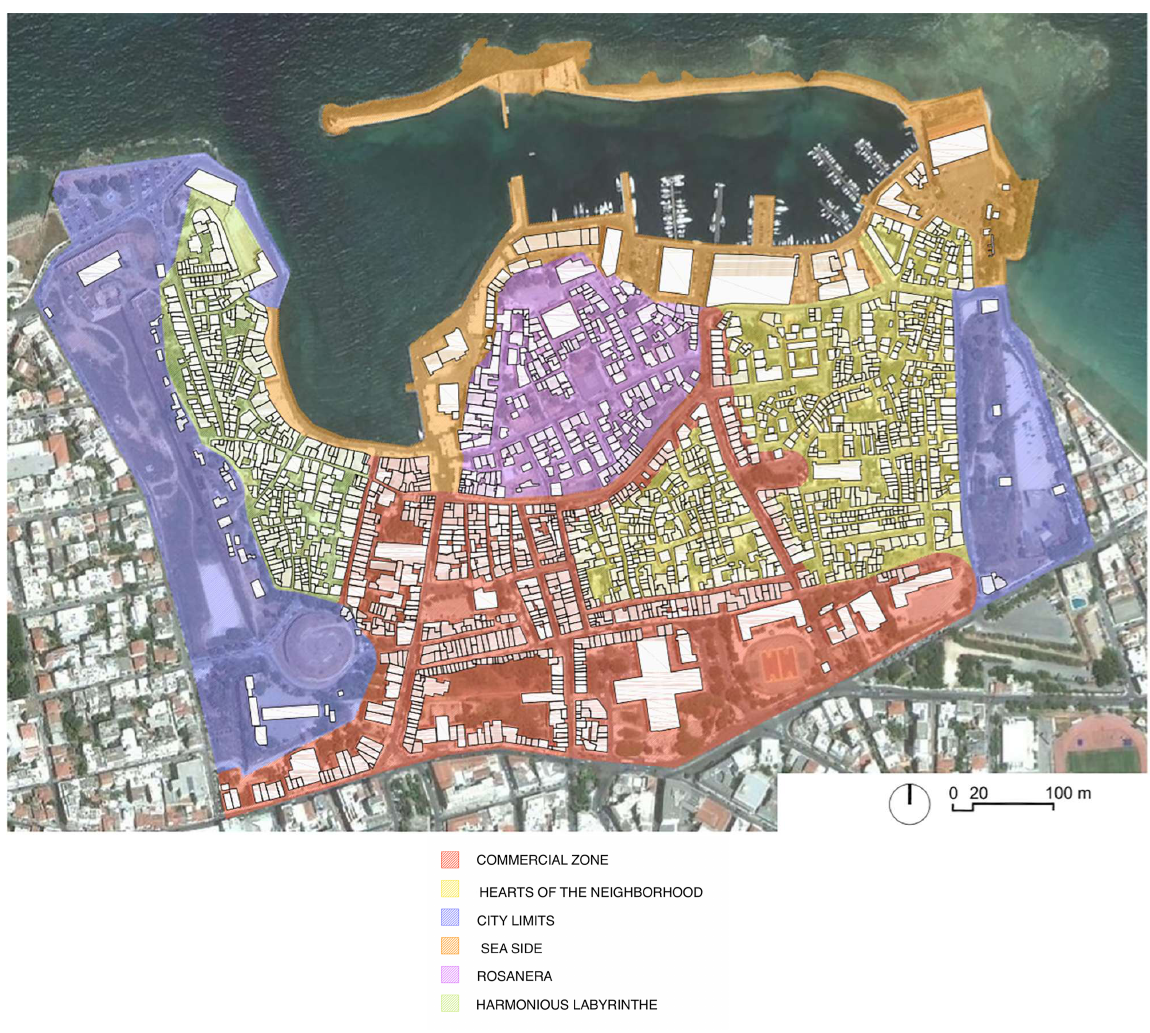
Figure 12: Sound identities map of the Old city centre and port of Chania U.A.,